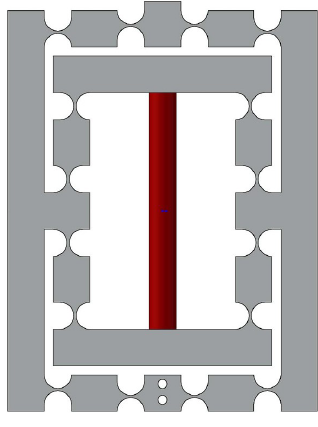
Figure 4. Two-stage bridge type of the amplifier (the red part is piezoelectric translator (PZT)